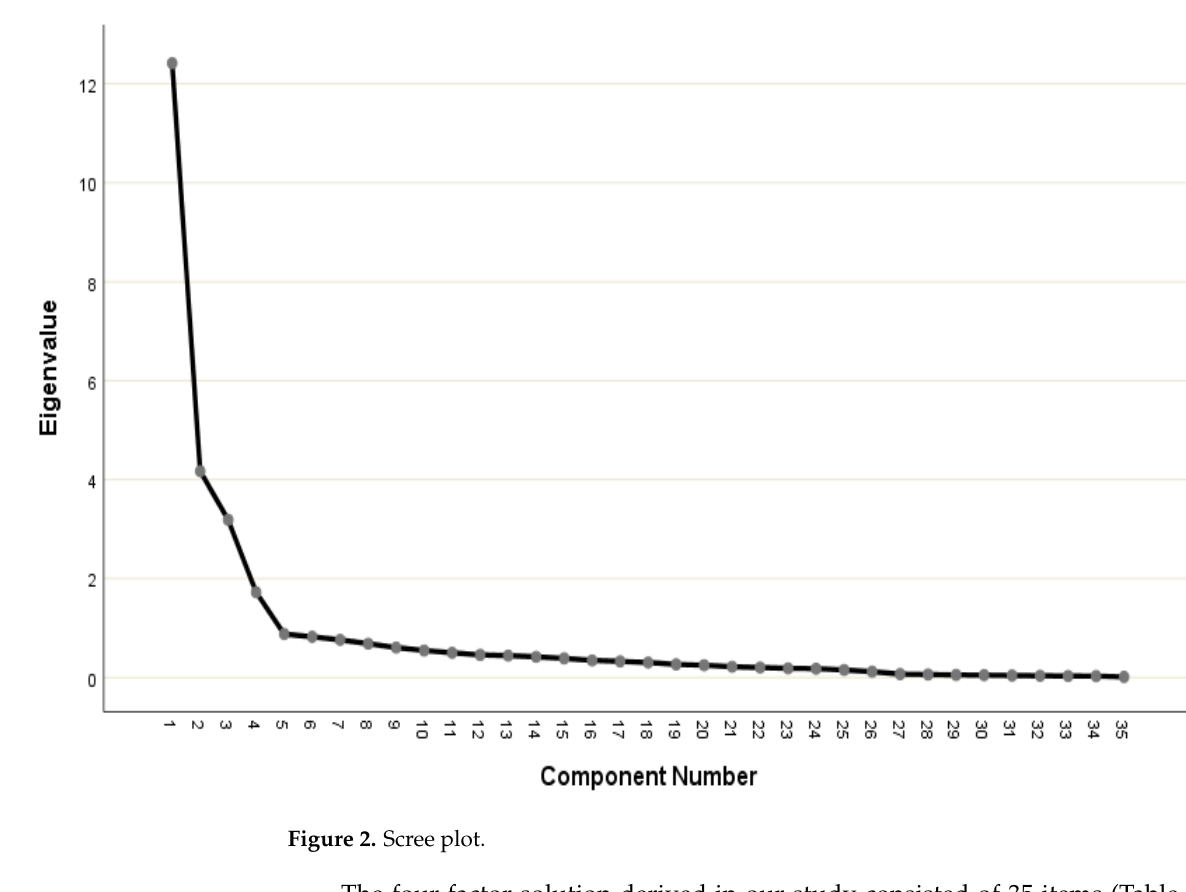
Figure 1. Confirmatory factor analysis of the Greek EBP-COQ Prof .